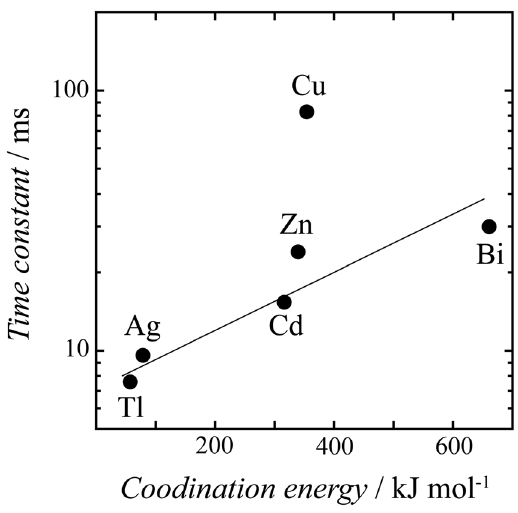
Figure 4. Correlation between the time constant of X–ray intensity decay and the coordination energy of each single hydration water of M(H 2 O) 6n + .